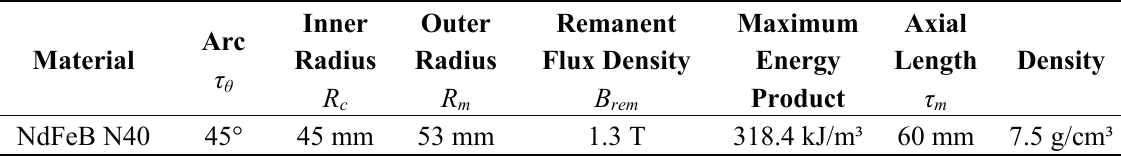
Table 2. Characteristics of the NdFeB permanent